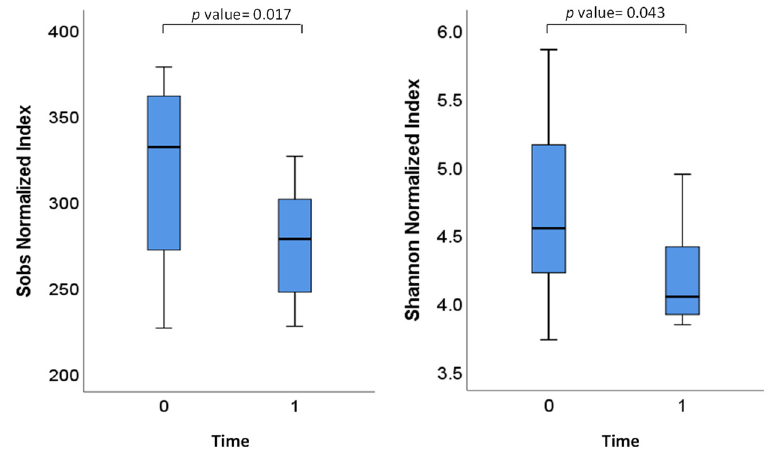
Figure 2. Comparison of Sobs and Shannon indexes before (T0) and after one month (T1) of isoflavone treatment in eight menopausal women. The lines inside the rectangles indicate the medians and the whiskers indicate the maximum and minimum values. Analysis was done using the nonparametric Wilcoxon signed-rank test to determine differences between T0 and T1.